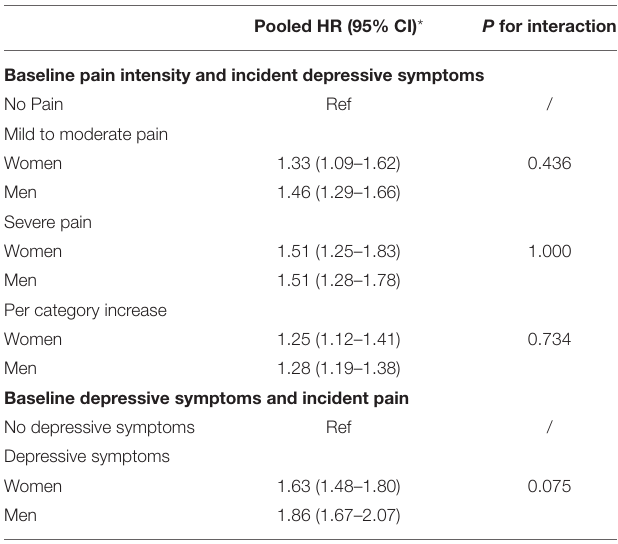
TABLE 4 | Modifying effects of sex on the association between baseline pain intensity and incident depressive symptoms, and on the association between baseline depressive symptoms and incident